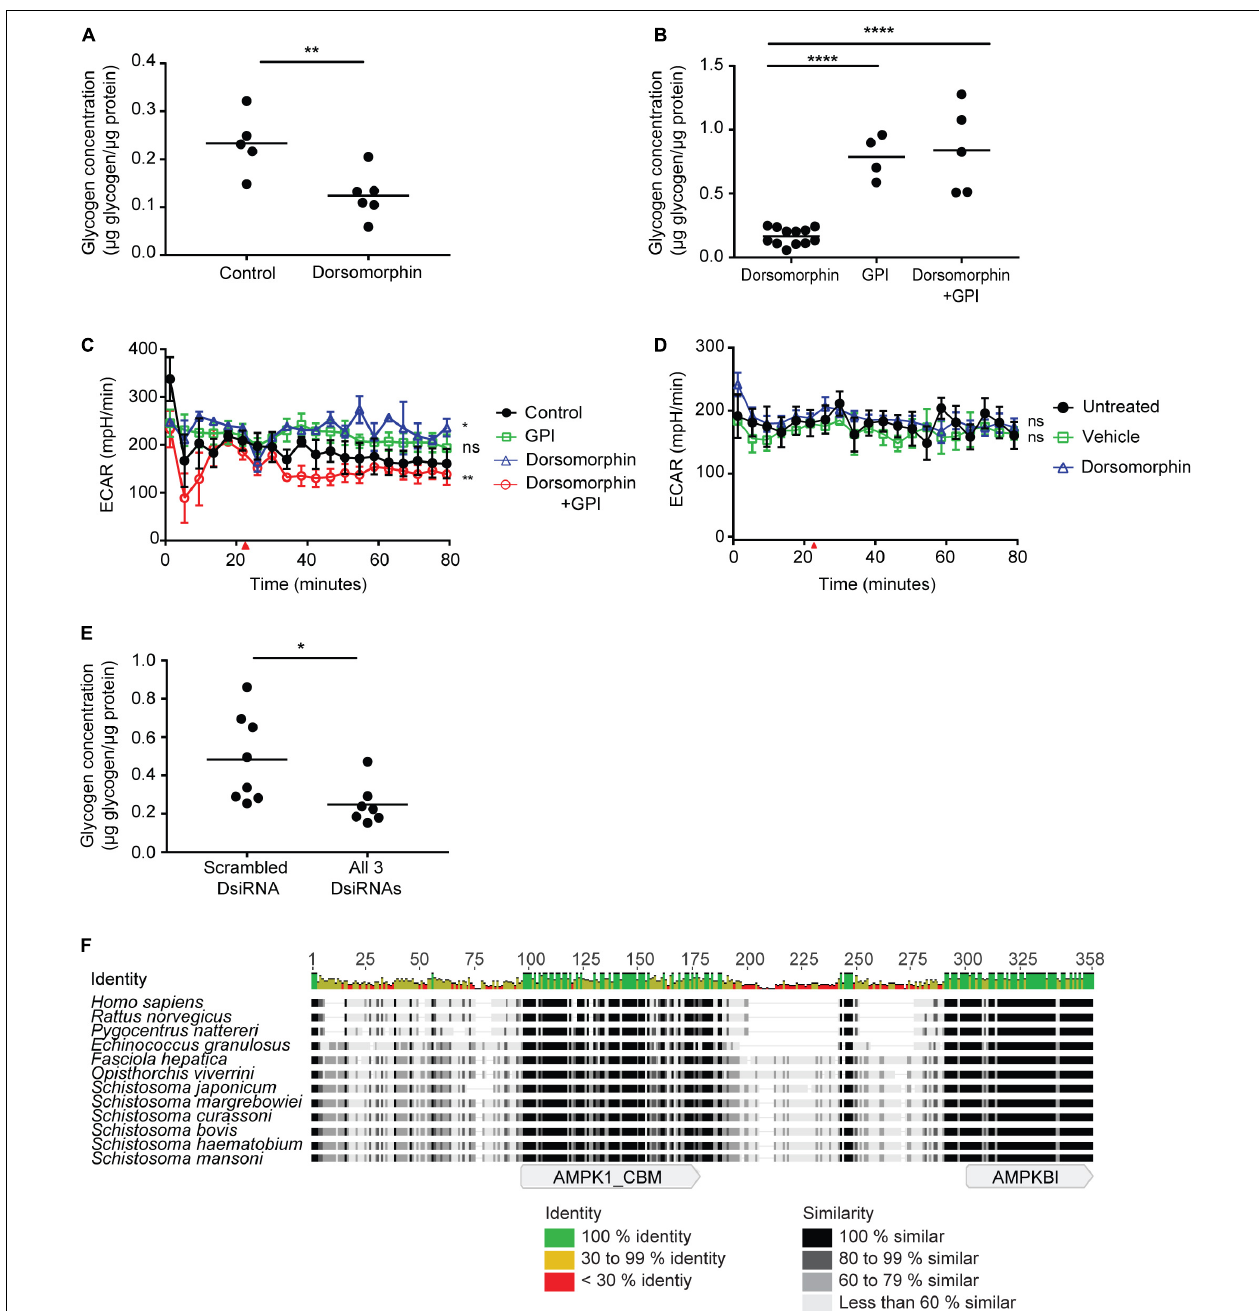
FIGURE 6 | AMPK regulates glycogen metabolism in adult schistosomes. (A) Freshly isolated adult schistosomes were incubated in either medium alone (control) or medium supplemented with 10 µ M dorsomorphin. After 24 h, lysates were prepared and glycogen content was measured. (B) Freshly isolated adult schistosomes were incubated in medium supplemented with 10 µ M dorsomorphin, 75 nM glycogen phosphorylase inhibitor (GPI) or 10 µ M dorsomorphin combined with 75 nM GPI. After 24 h, lysates were prepared and glycogen content was measured. In (A,B) , each data point indicates one schistosome pair, and graphs are representative of at least 3 independent experiments. (C) ECAR of adults worms exposed to 10 µ M dorsomorphin, 75 nM GPI, or a both combined, was measured using the Agilent Seahorse XFe96 instrument. Red arrow indicates the time point at which compounds were introduced into parasite culture media. Each data point is the average of at least 3 biological replicates. (D) 72 h post-electroporation of adult S. mansoni worms with all 3 AMPK α -targeting DsiRNAs, ECAR upon exposure to 10 µ M dorsomorphin was compared to vehicle, or no treatment, using the Agilent Seahorse XFe96 system. Red arrow indicates the time point at which compounds were introduced into parasite culture medium. Each data point is the average of at least 3 biological replicates. (E) Freshly isolated adult schistosomes were electroporated with either control scrambled DsiRNA or a combination of all 3 AMPK α -targeting DsiRNAs. 72 h post-electroporation, lysates were prepared and glycogen content was measured. Each data point represents a biological replicate. (F) The amino acid sequence of S. mansoni AMPK β (MN480434) aligned with AMPK β sequences of Homo sapiens (NP_006244) , Rattus norvegicus (NP_114182.1) , Pygocentrus nattereri (XP_017539403.1) , Echinococcus